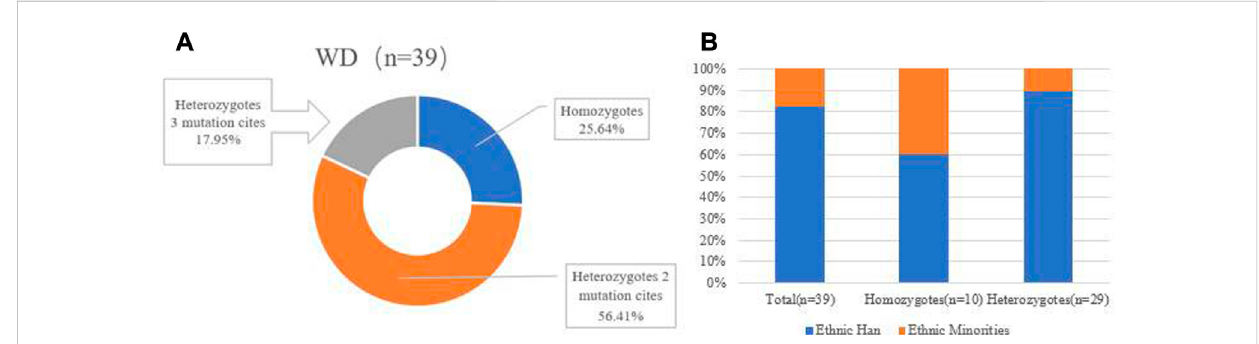
FIGURE 2 (A) Distribution of genotype in total patients with WD. (B) Distribution of genotype in patients from different ethnic groups ( p =